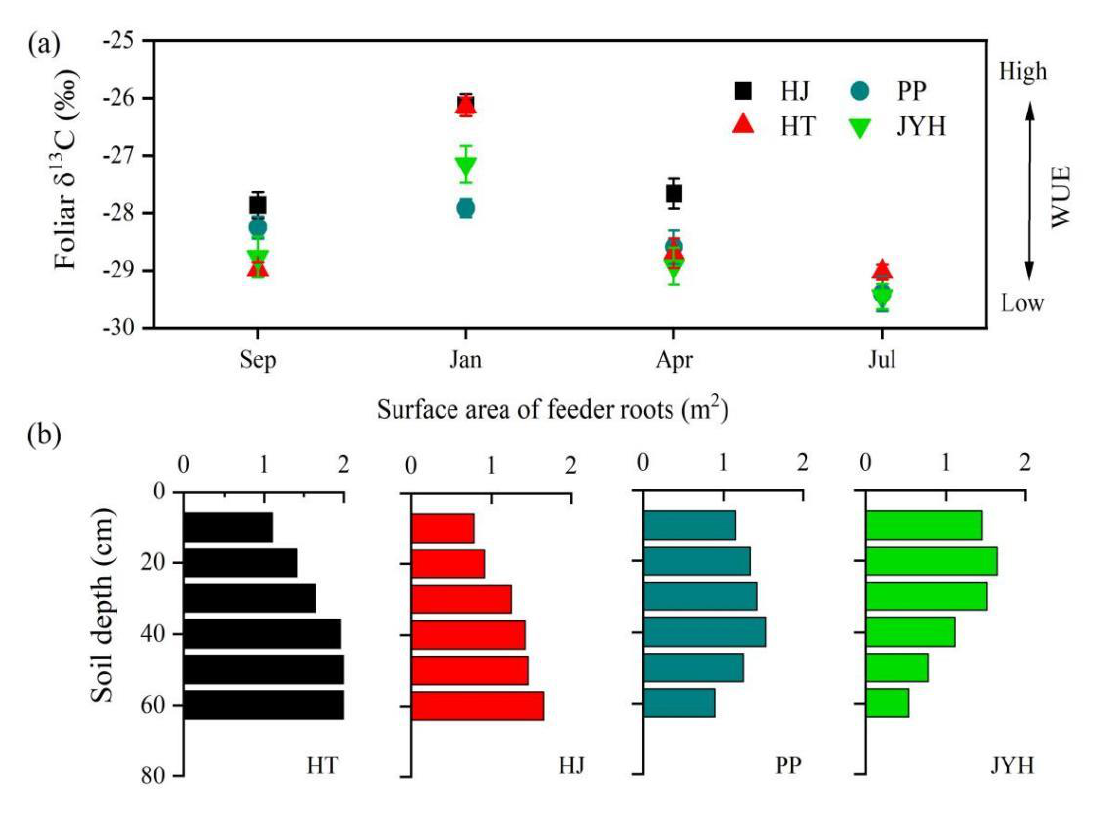
Figure 9. ( a ) Seasonal variation of δ 13 C values in leaves of HT, HJ, PP, and JYH. ( b ) Profile distribution of root surface area of four species. Error bars represents standard error.